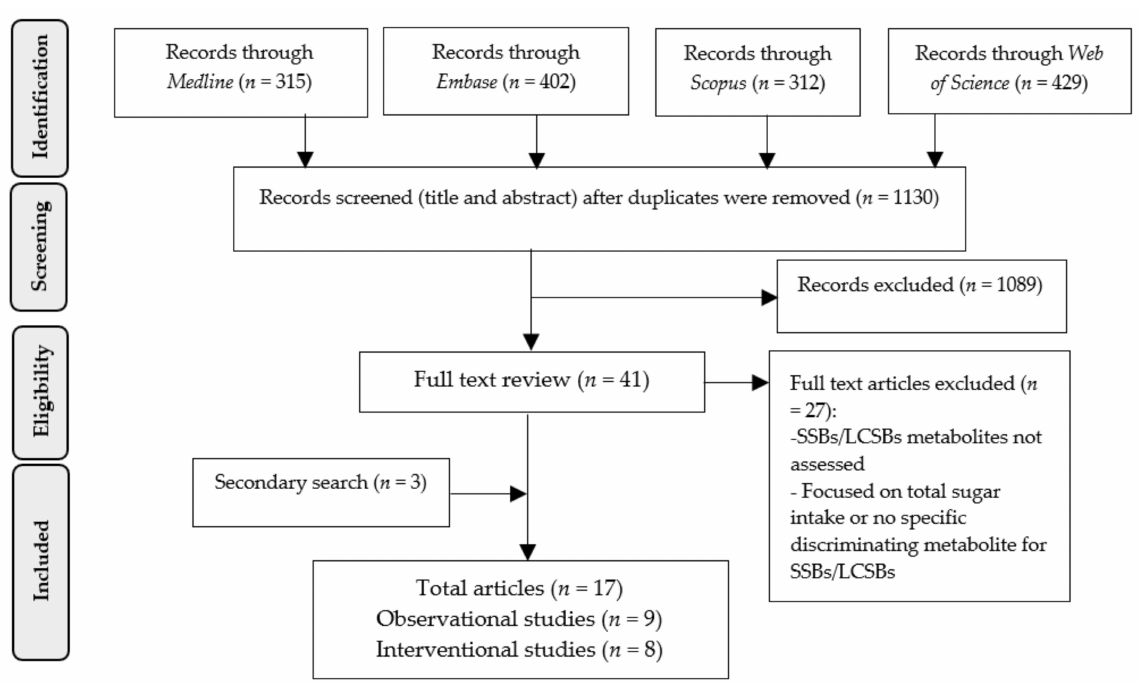
Figure 1. PRISMA flowchart on the screening process and selection of papers reporting biomarkers of SSBs and LCSBs as